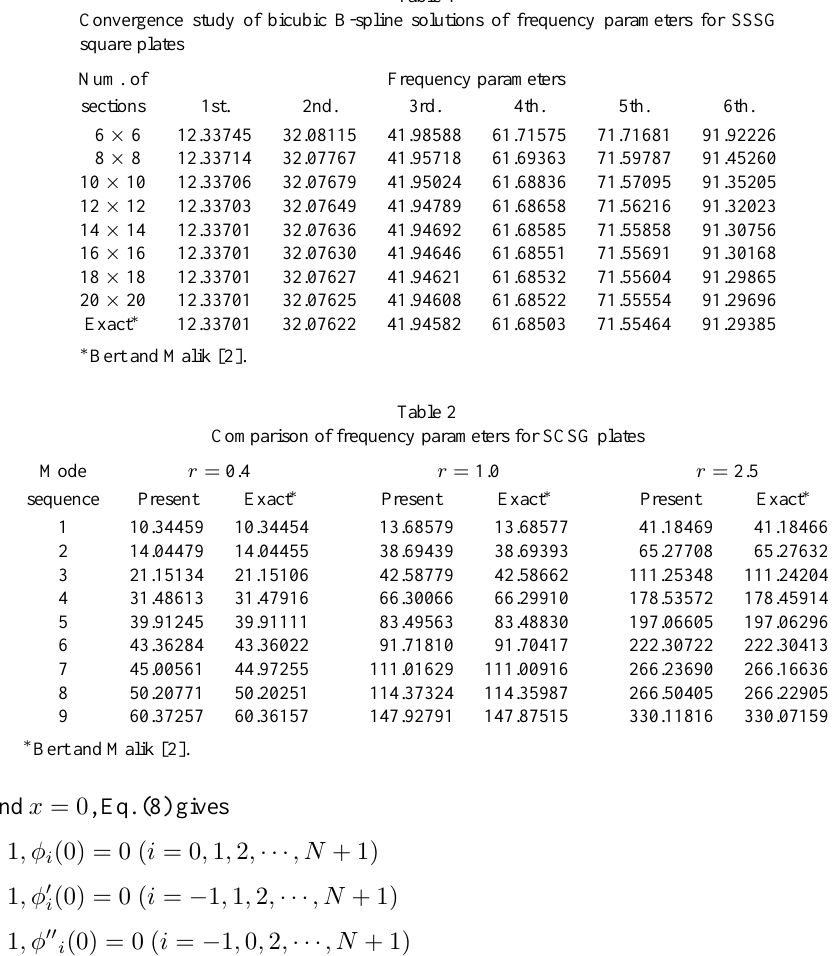
Table 1 Convergence study of bicubic B-spline solutions of frequency parameters for SSSG